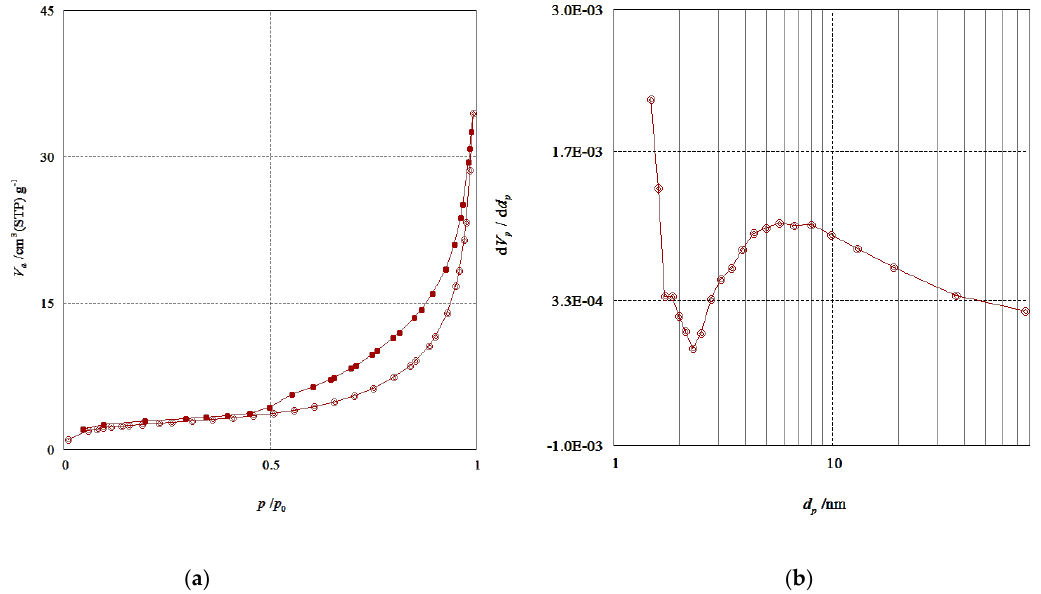
Figure 9. ( a ) N 2 adsorption-desorption isotherms of Mn:ZnS QDs. ( b ) Pore size distribution calculated from the adsorption branch.